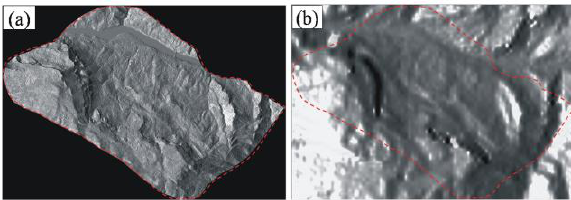
Figure 6. Simulated intensity images of two DEMs: (a) LiDAR DEM and (b) SRTM